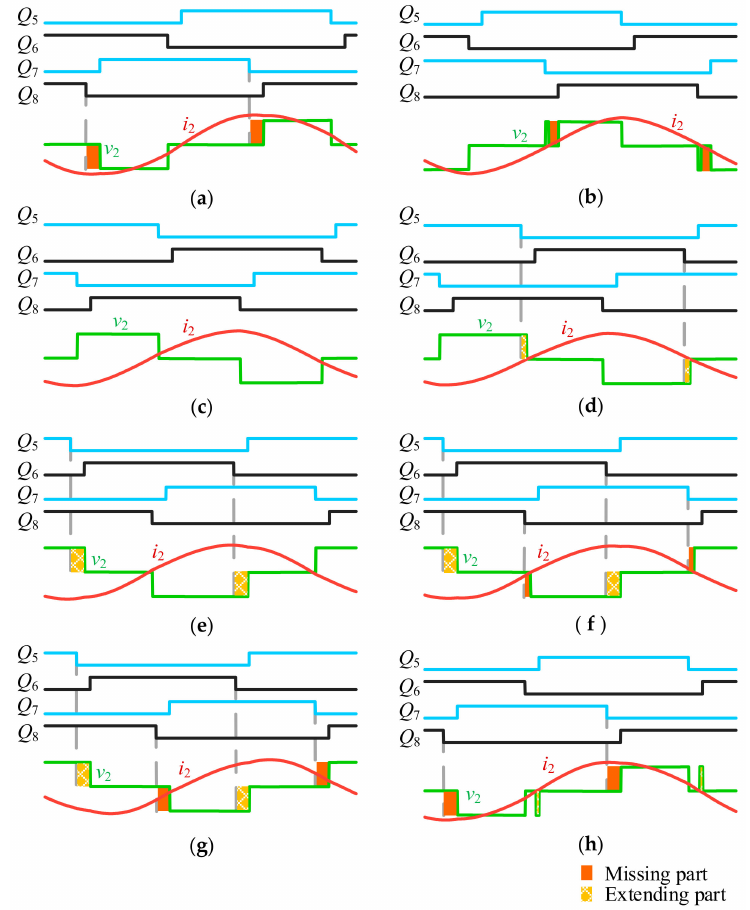
Figure 4. Dead-time effect of the DAB WPT system where the orange and yellow areas present the missing and extending parts of the voltage, respectively. ( a ) Region 1; ( b ) Region 2; ( c ) Region 3; ( d ) Region 4; ( e ) Region 5; ( f ) Region 6; ( g ) Region 7; ( h ) Region